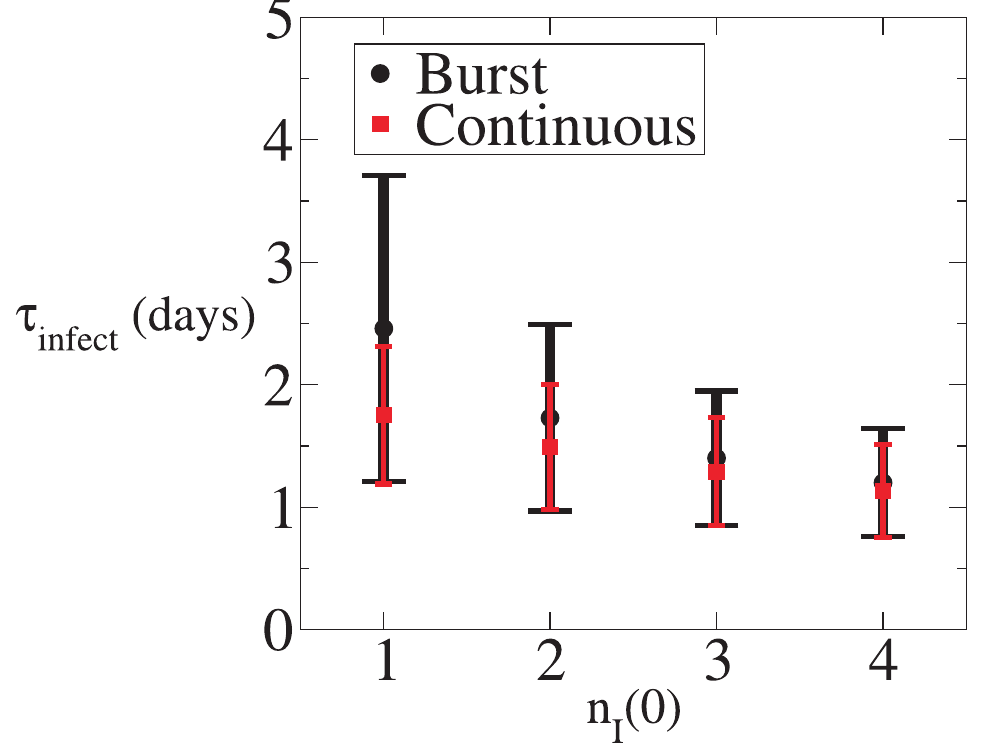
Figure 11. Mean time to reach 32 infected cells versus n I (0) . Black: Burst Model. Red: Continuous Production Model. doi:10.1371/journal.pcbi.1001058.g011 PLoS Computational Biology |